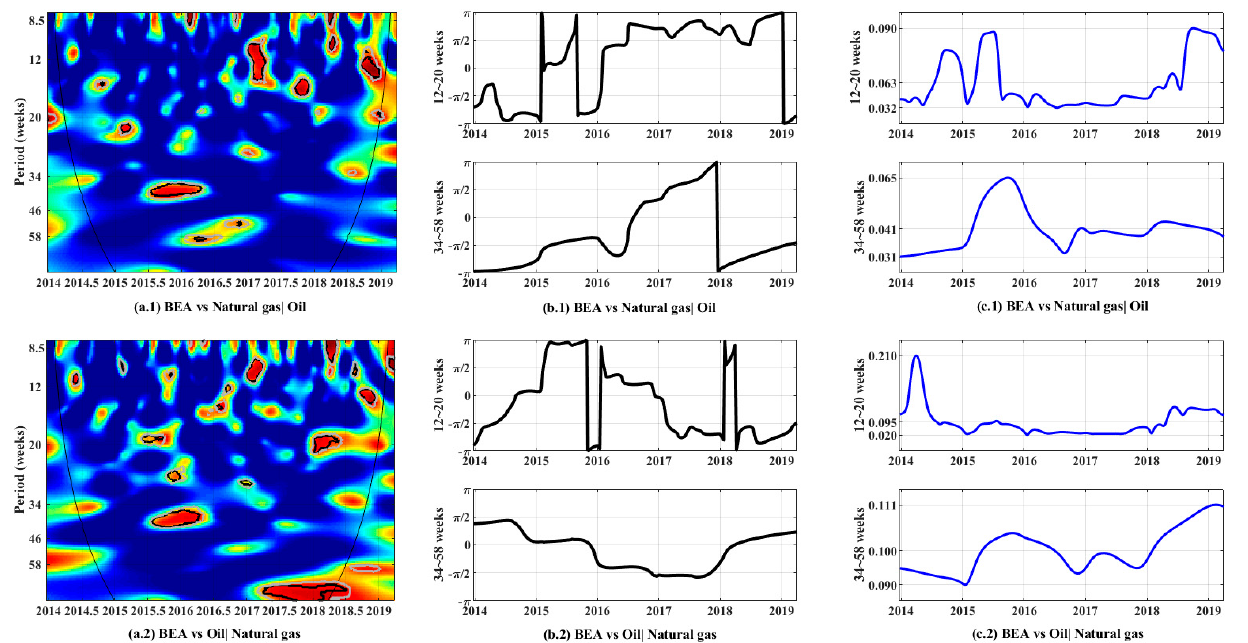
Figure 3. Partial wavelet coherency, phase difference, and wavelet gain. Note: ( a ) partial wavelet coherency between Beijing carbon price and natural gas price ( a.1 ) or oil price ( a.2 ); ( b ) partial wavelet phase difference between Beijing carbon price and natural gas price ( b.1 ) or oil price ( b.2 ); and ( c ) partial wavelet gain between Beijing carbon price and natural gas price ( c.1 ) or oil price ( c.2